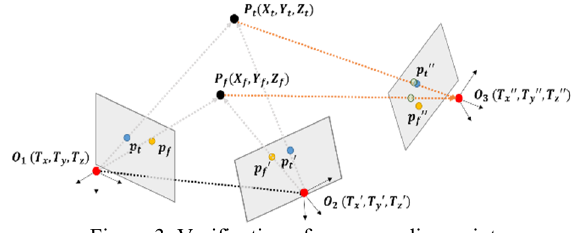
Figure 3. Verification of corresponding point MMS images contain moving objects such as human, and vehicles. Often they are extracted as features and not eliminated as outliers. They reduce the accuracy of estimation. Figure 3 explains corresponding point verification. When the true model point ( P t ) is projected onto O 3 , it has a small separation from the image point ( (cid:1868) (cid:3047)(cid:4593)(cid:4593) ). However, in the case of the false model point ( P f ), it shows a large separation when projected onto O 3 . Therefore, we projected the model points onto the images and calculated the separation distance from the corresponding image points. Based on the results, the appropriate model point was